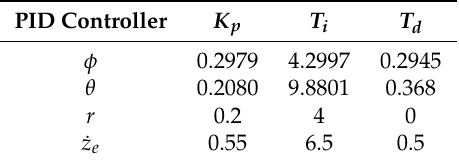
Table 2. Pid parameters using a genetic algorithm.